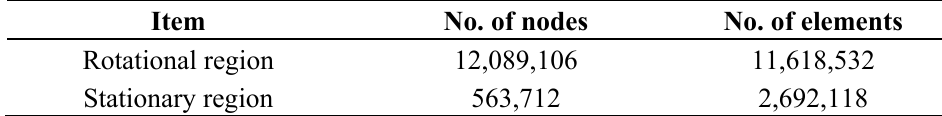
Table 2. Mesh information for analysis domain of 6 MW wind farm (case 3).